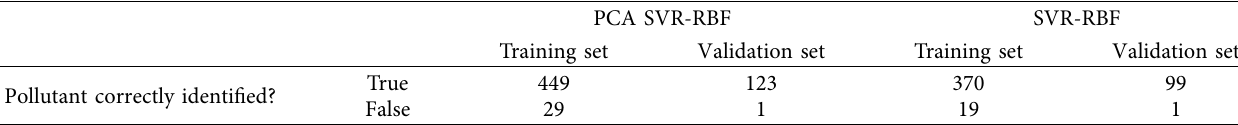
Table 14: AQI misidentified cases breakdown.